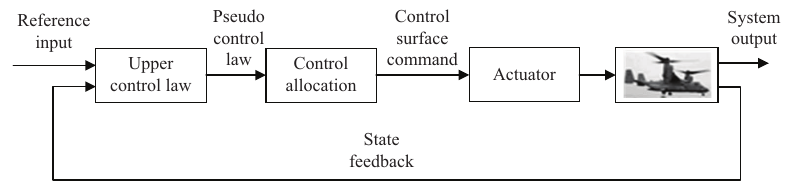
Figure 8. Structure of overdrive control system based on control